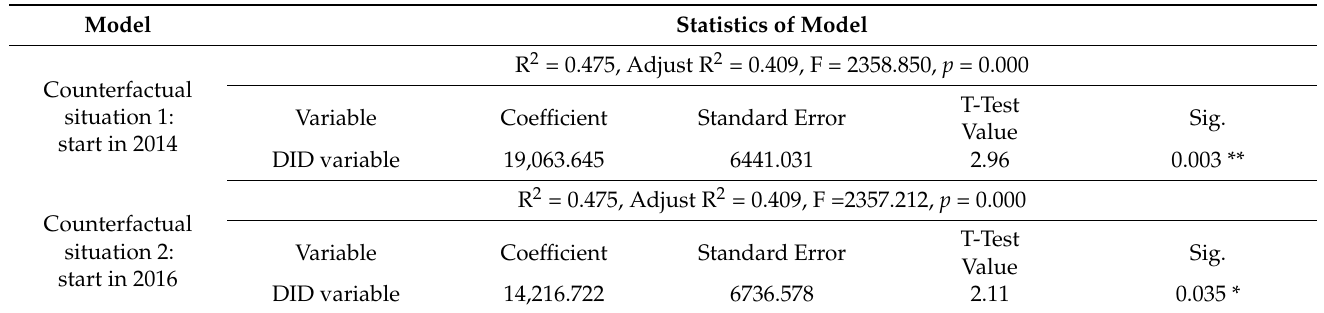
Table 3. Estimation results of the counterfactual